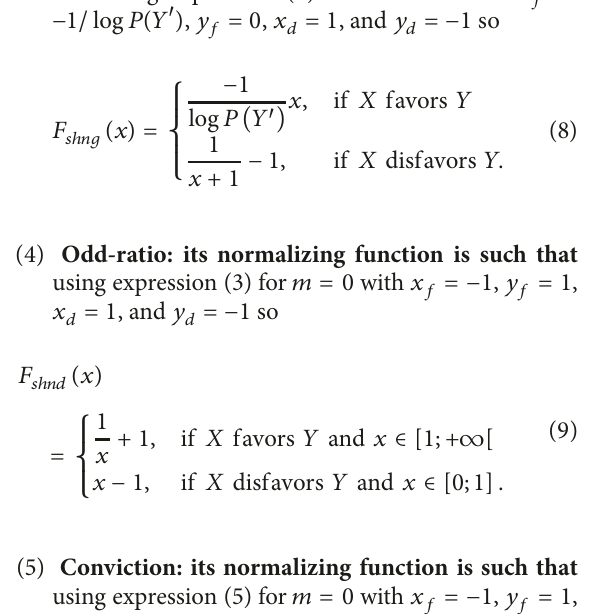
Figure 2: Geometric interpretation of the normalization function of the “Cost Multiplying”